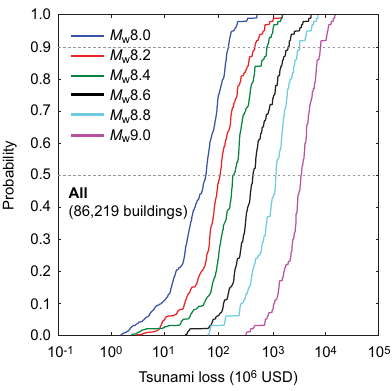
Figure 8. Probability distributions of total tsunami loss for different earthquake